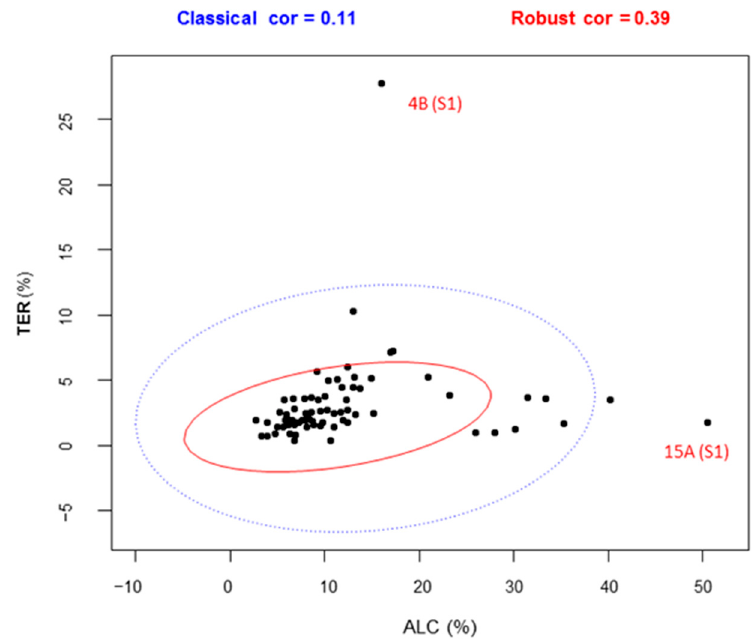
Figure 4. Correlation analysis of alcohol (ALC) and terpene (TER) percentages based on total areas of the melon compounds identified with match quality > 50, and without exogenous compounds). Classical and robust 97.5% confidence ellipses of the data (blue and red, respectively). The robust method used 50% of the observations for minimum covariance determinant (MCD) estimations. The strong outliers labeled are the fruits 4B and 15A from season 1.